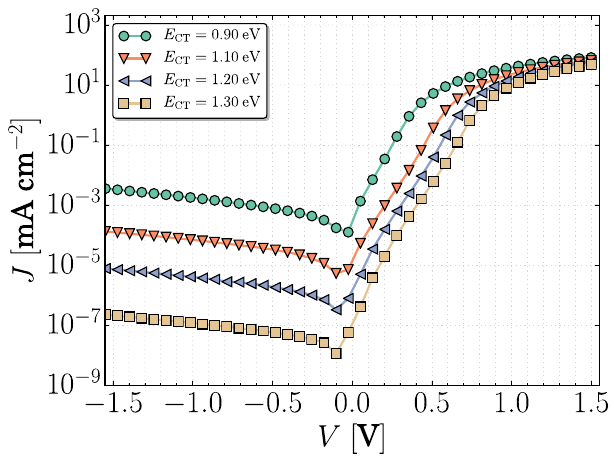
Fig. 5 Simulated dark JV characteristics for different E CT . N t , E t , and β SRH were kept constant as described in Supplementary